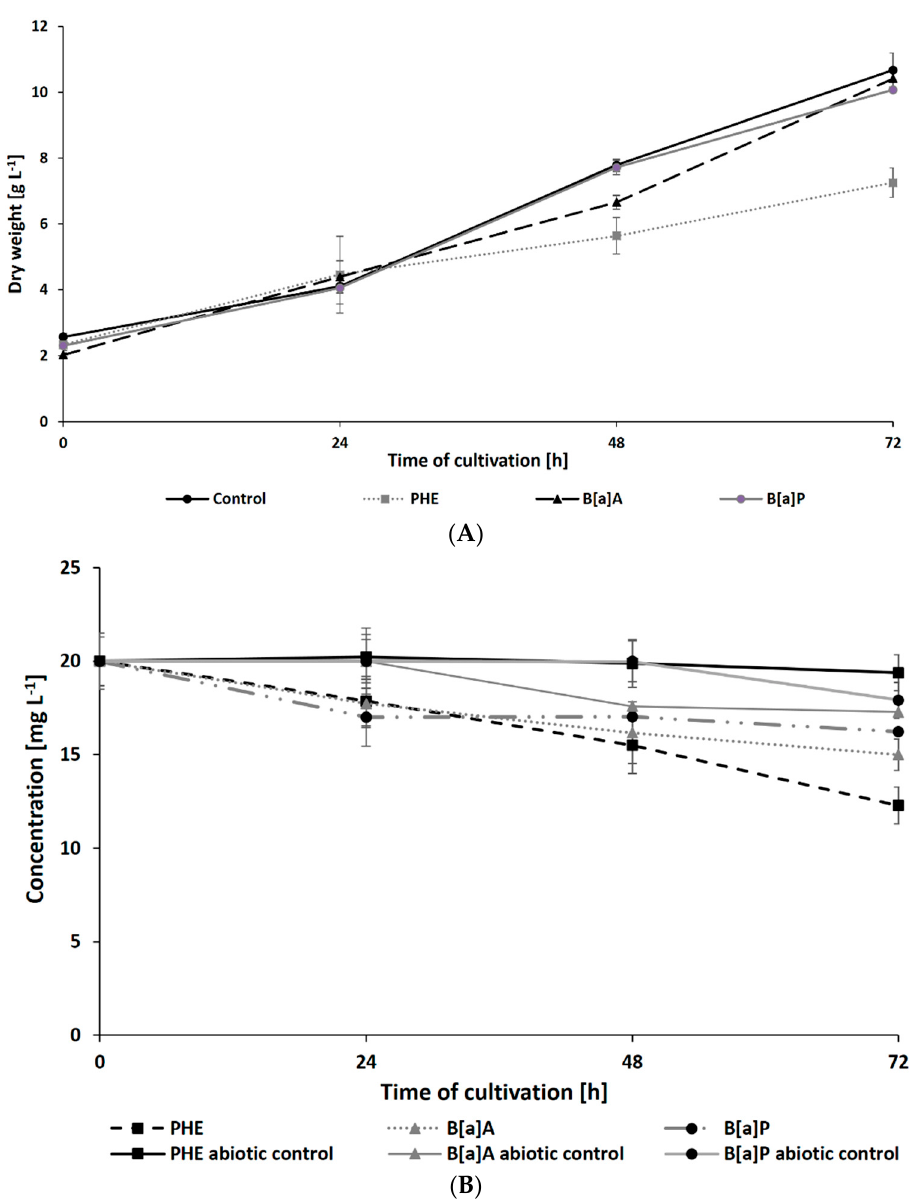
Figure 2. Dry weight of N. pironii ( A ) and PAH degradation of PAHs ( B ) during culture in Sabouraud medium containing PHE; B[a]A or B[a]P (20 mg L − 1 ). medium containing PHE; B[a]A or B[a]P (20 mg L − 1